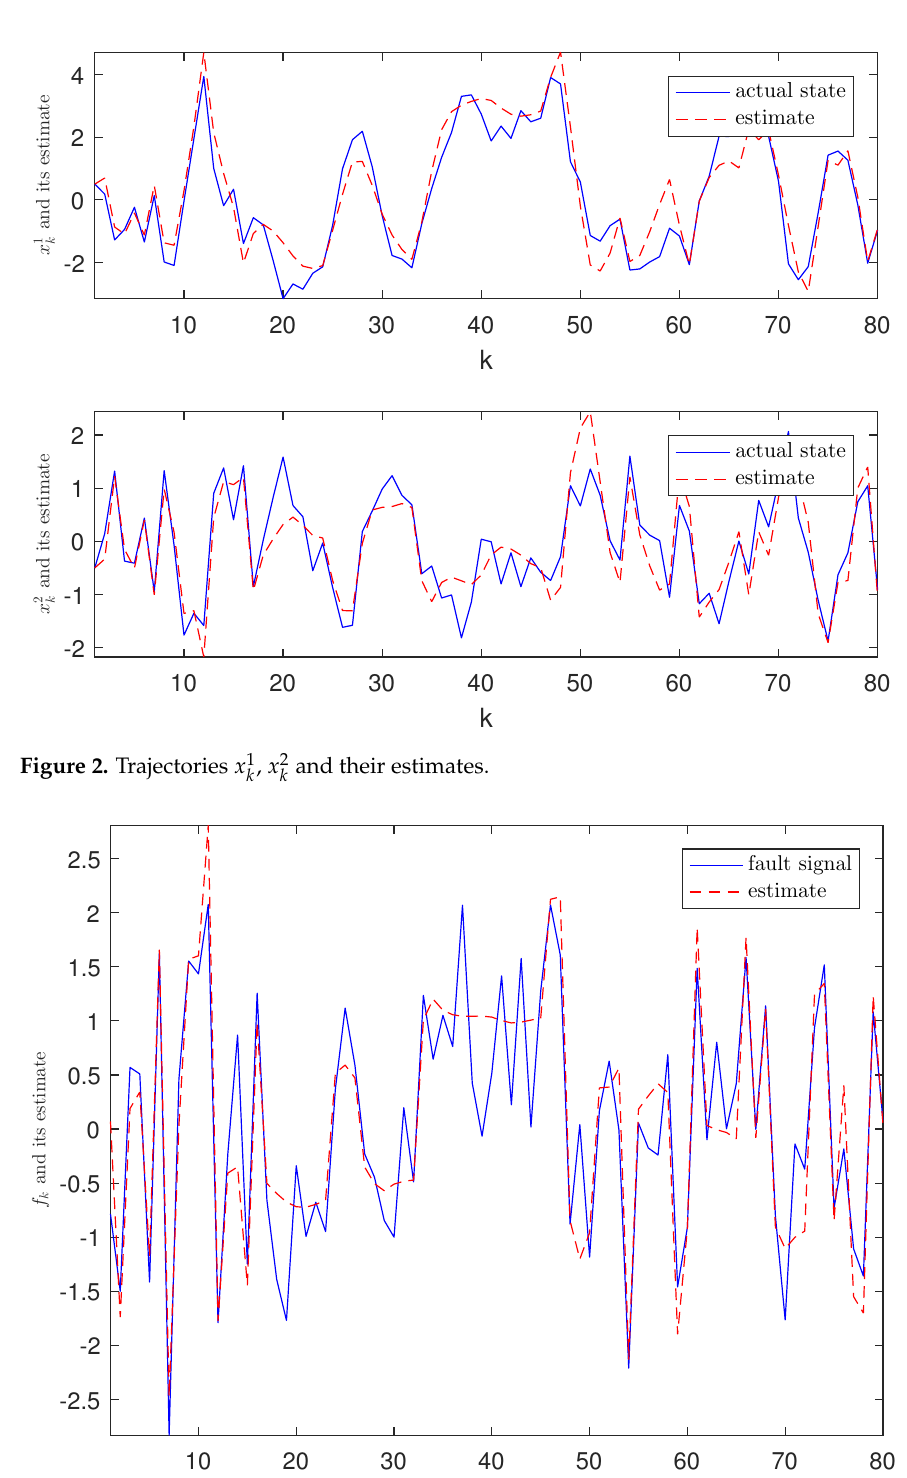
Figure 3. Trajectories of fault f k and its estimate.